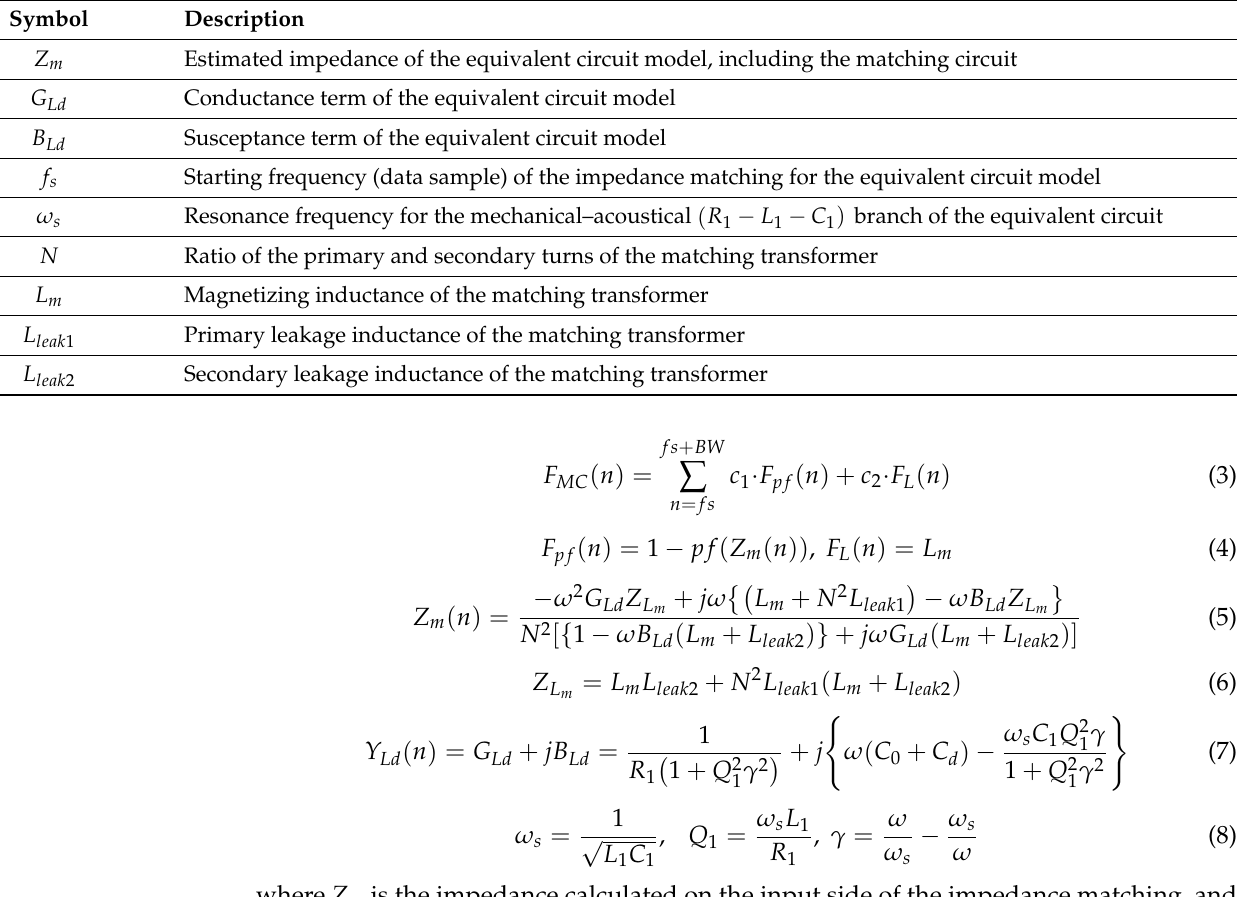
Table 2. The parameters for Equations